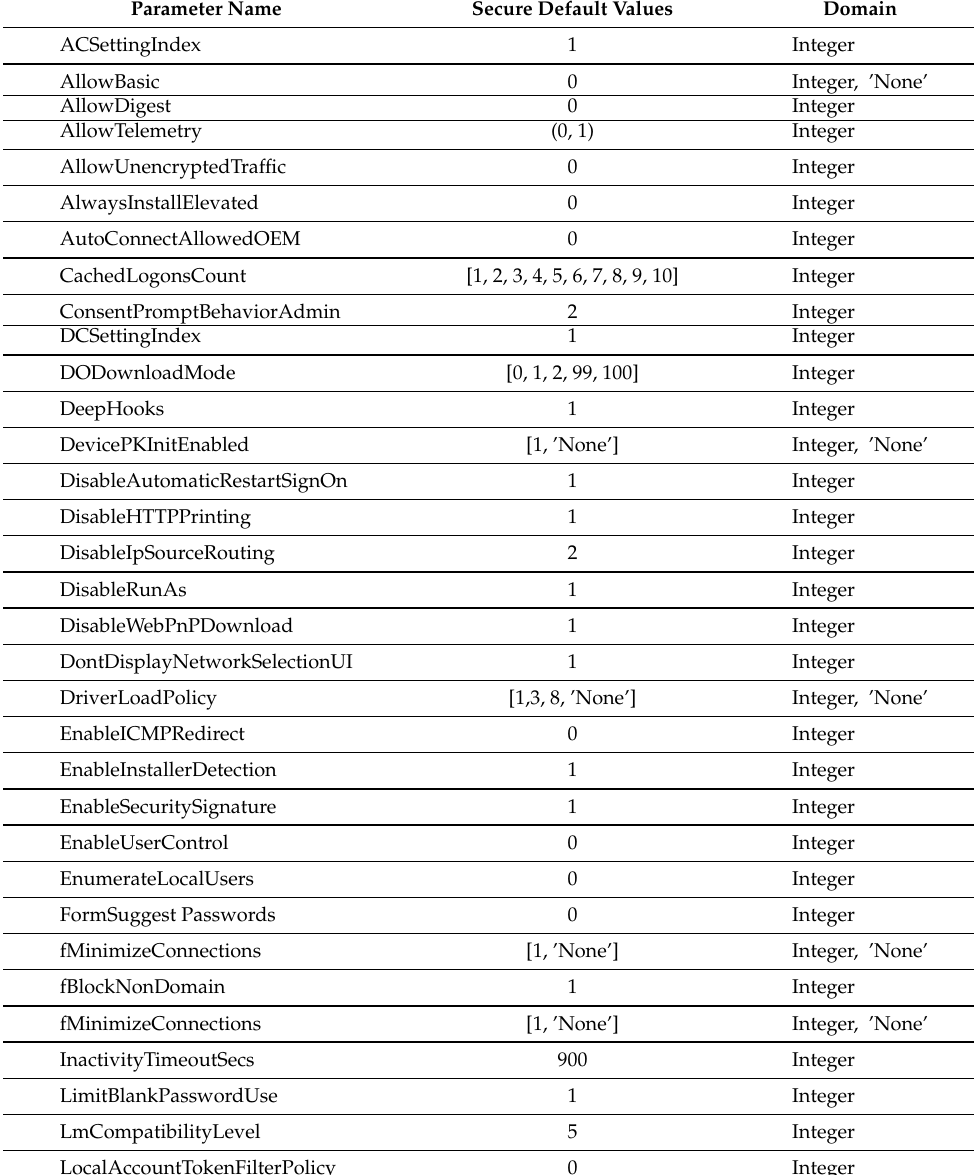
Table 1. A subset of configuration parameters of Windows 10